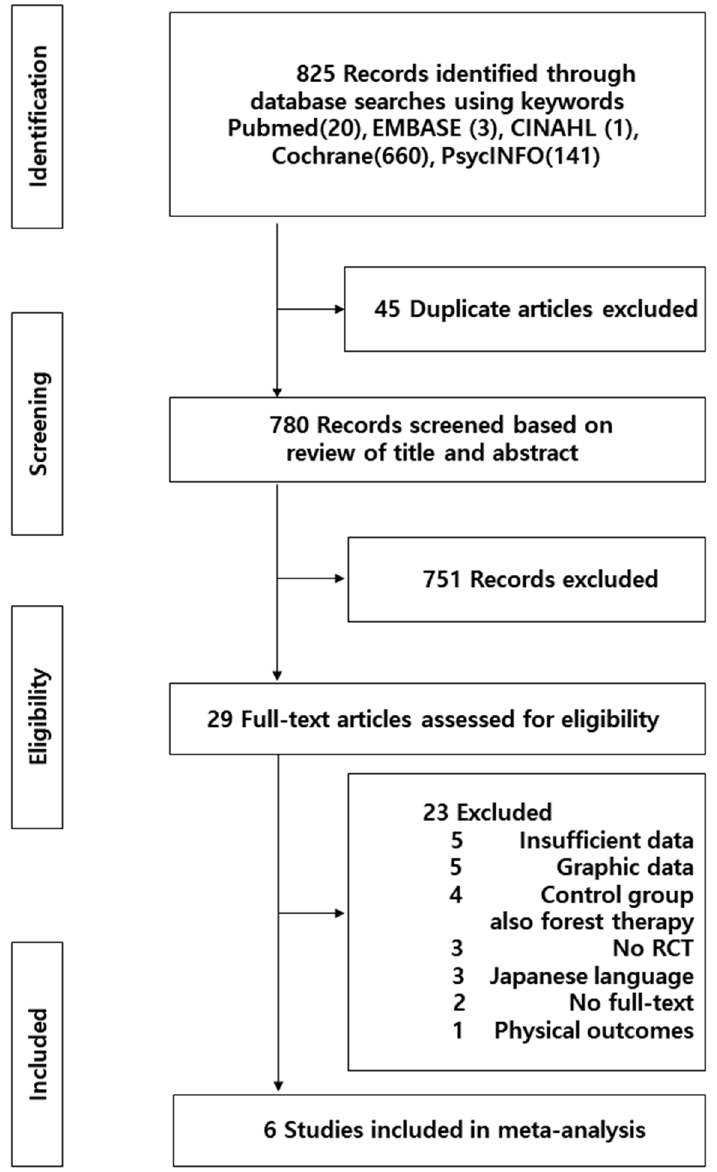
Figure 1. Flow diagram for the study selection process.